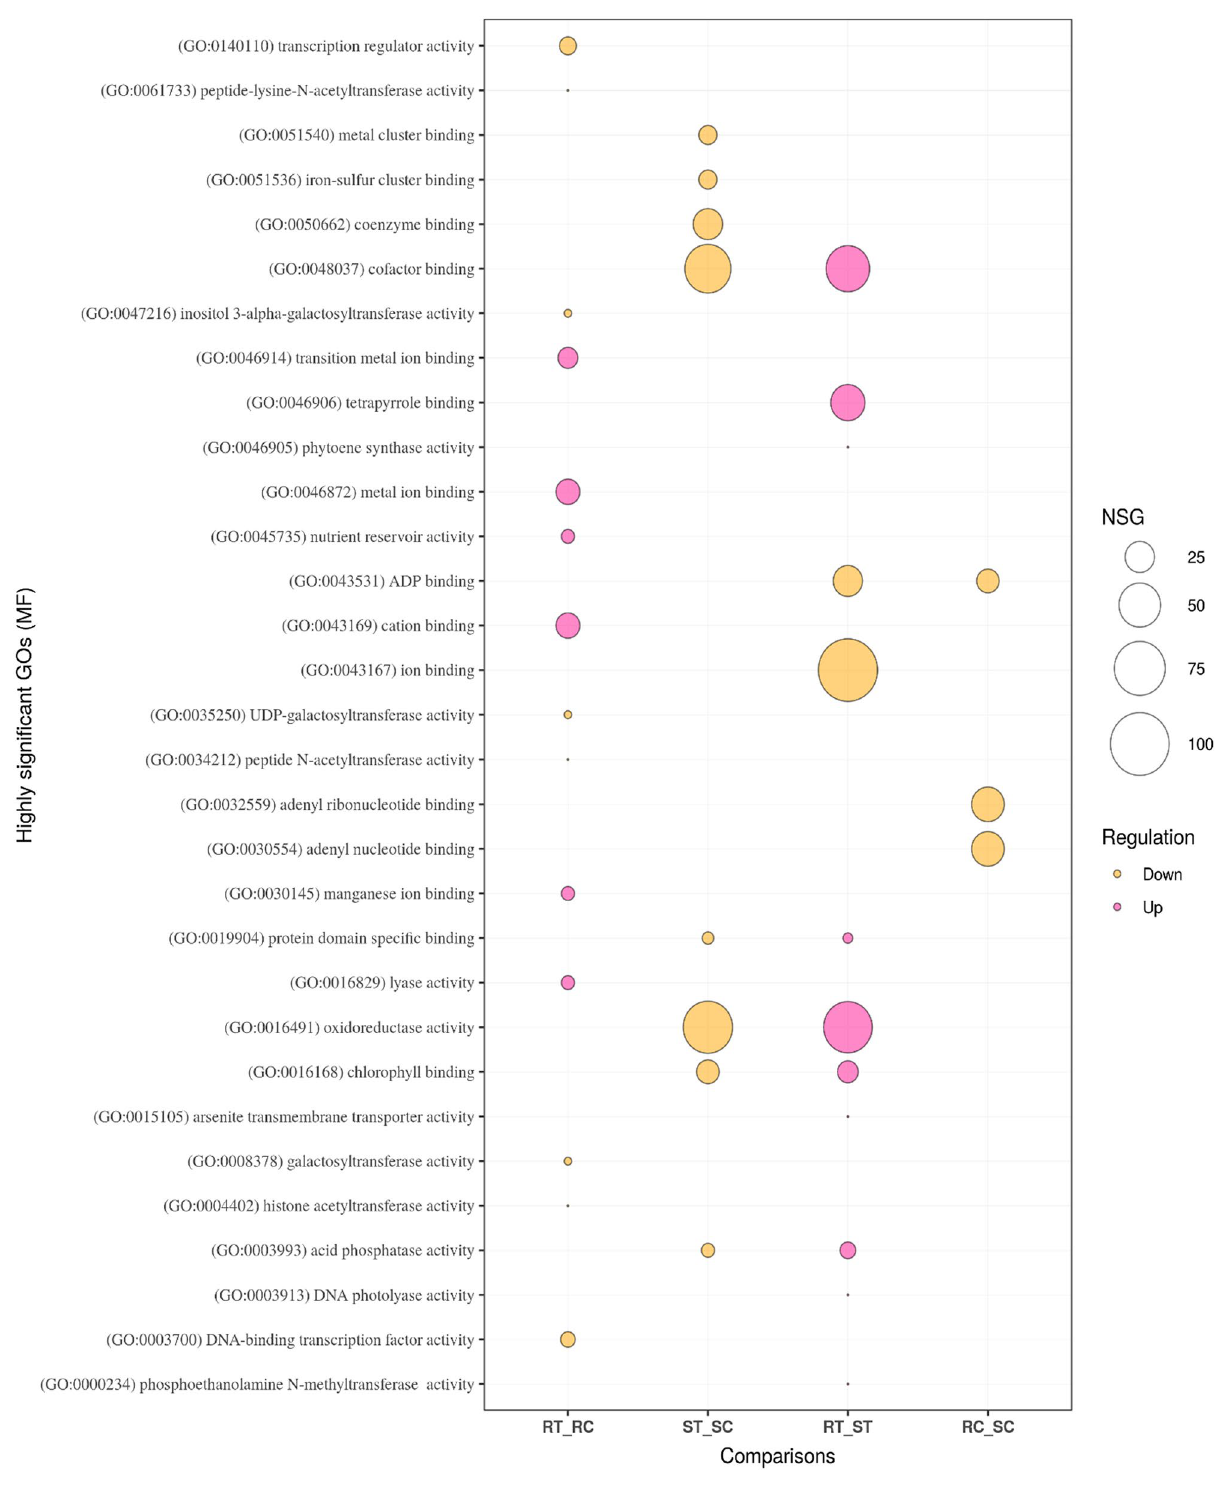
Figure 8. Bubble plot of the GO enrichment terms related to molecular function (MF). The size of the circles shows the number of significant genes (NSG) associated with each GO term. Purple and orange colors show up-regulated and down-regulated DEGs, respectively. RC (resistant control), RT (resistant treatment), SC (susceptible control), and ST (susceptible treatment). The plot was created using ‘ggplot2 version 3.3.5’ R/CRAN package (https:// ggplo t2. tidyv erse.